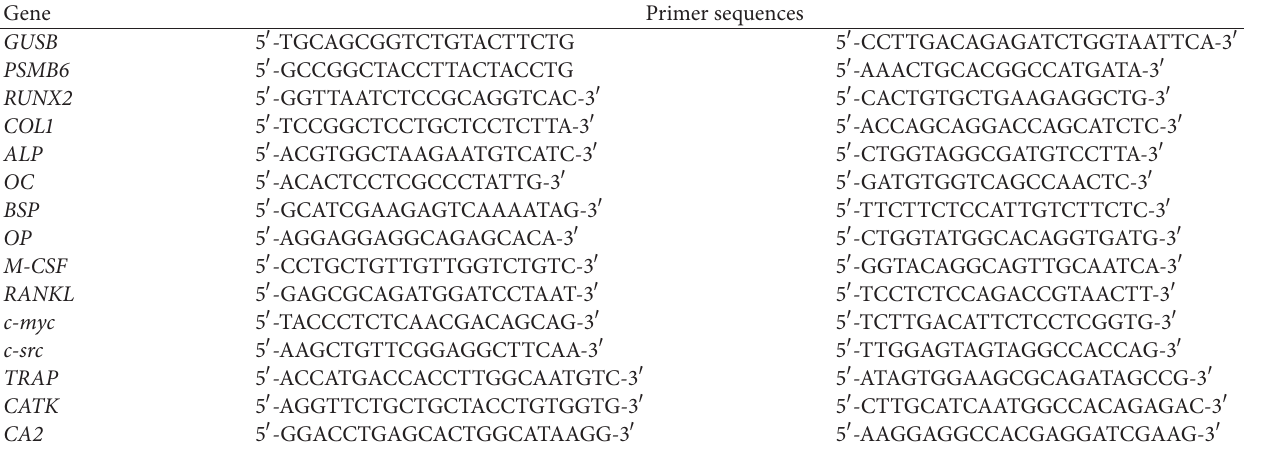
Table 1: qPCR primer sequences of the studied